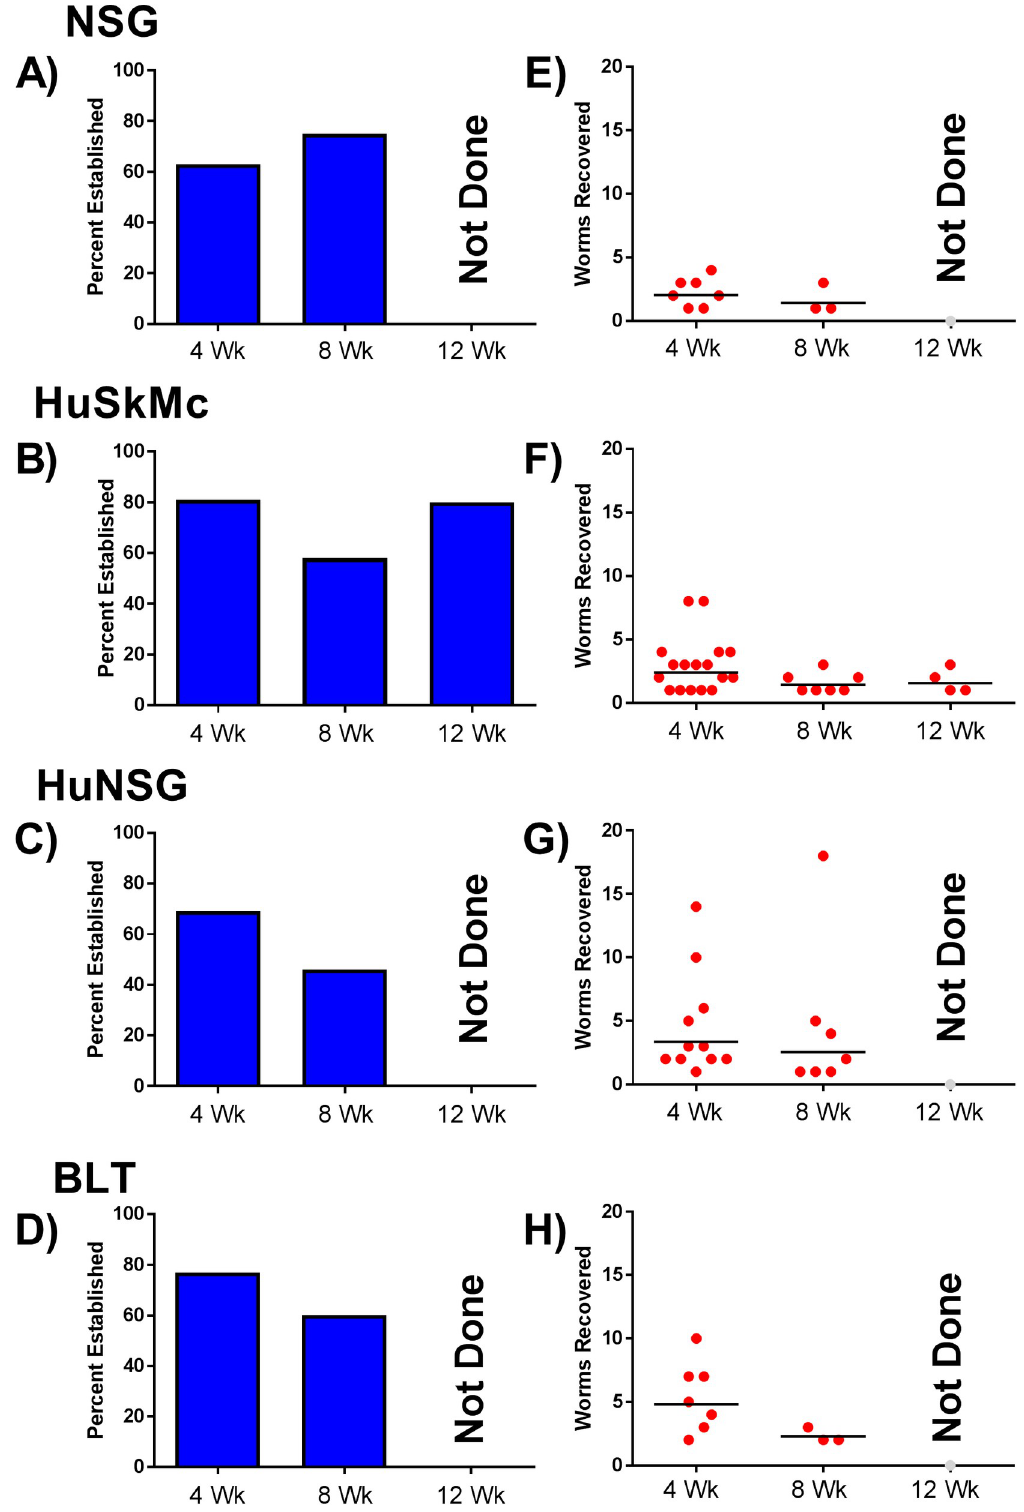
Fig 1. Survival of larval Onchocerca volvulus in four mouse models. O . volvulus L3 (100/mouse) were injected subcutaneously into 4 mouse models: (A,E) NSG mice (4 week n = 11 [2.3% Recovery], 8 week n = 4 [1.7% Recovery]), (B,F) Human skeletal muscle cell engrafted NSG mice (HuSkMc) (4 week n = 21 [3.0% Recovery], 8 week n = 12 [1.6% Recovery],